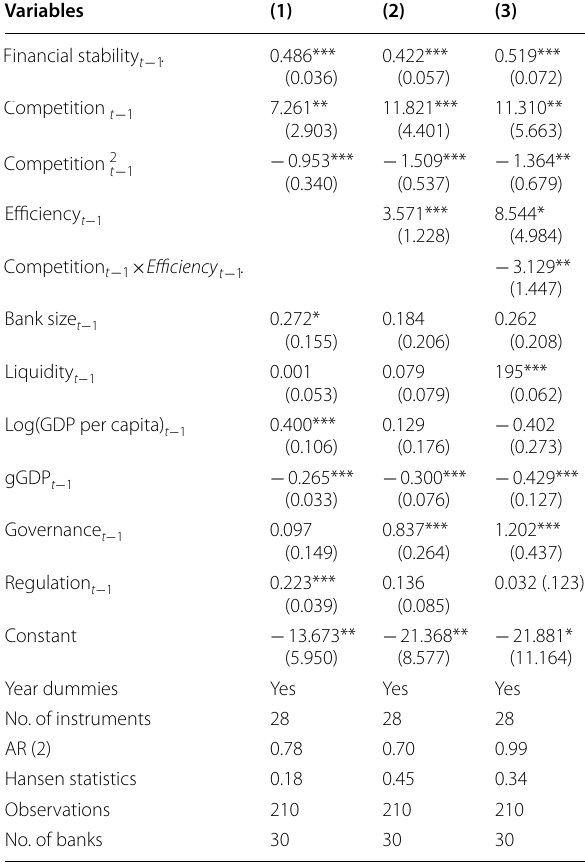
Table 3 Robustness check using alternative measure of competition and